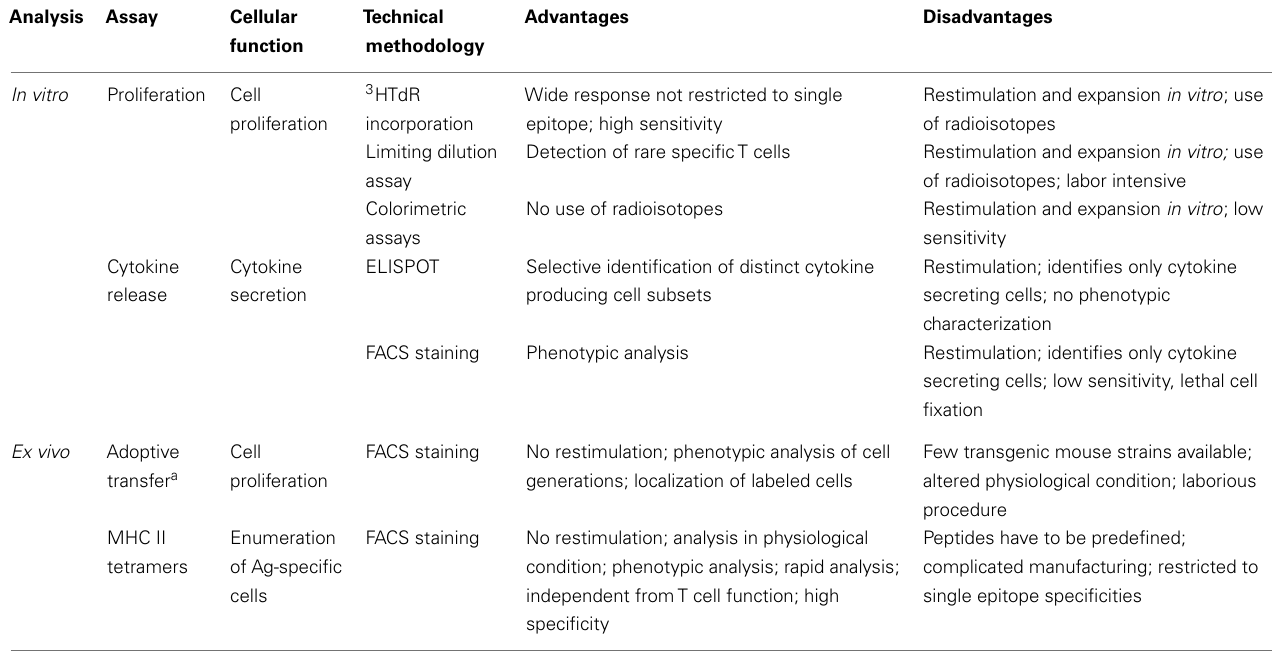
Table 1 | Methods used for studying antigen-specificT cell priming in humans and animals . Analysis